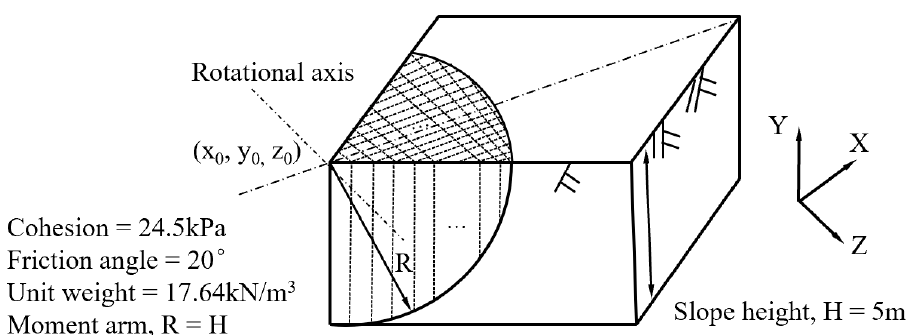
Figure 5. Illustration of the hypothetical example.